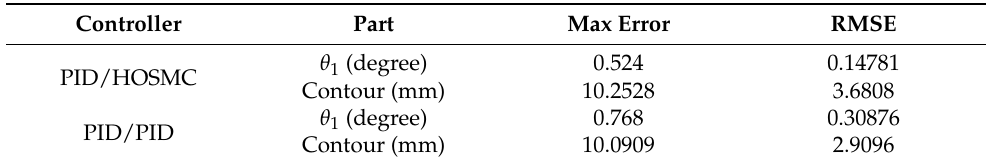
Table 11. Comparison table of the tracking results on the circular trajectory at a lower load of an robot arm.